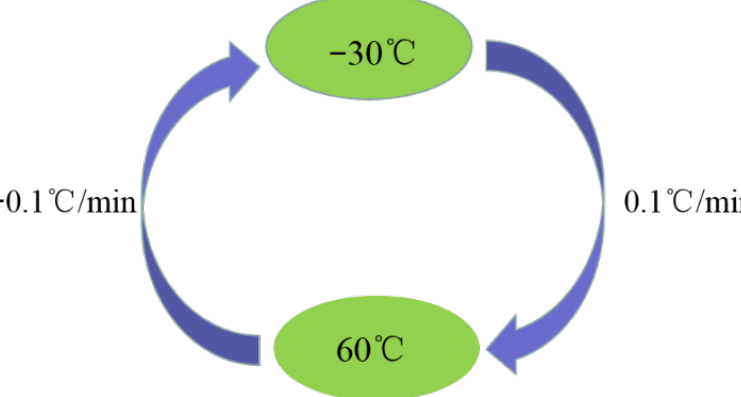
Figure 12. Process of the full relative humidity